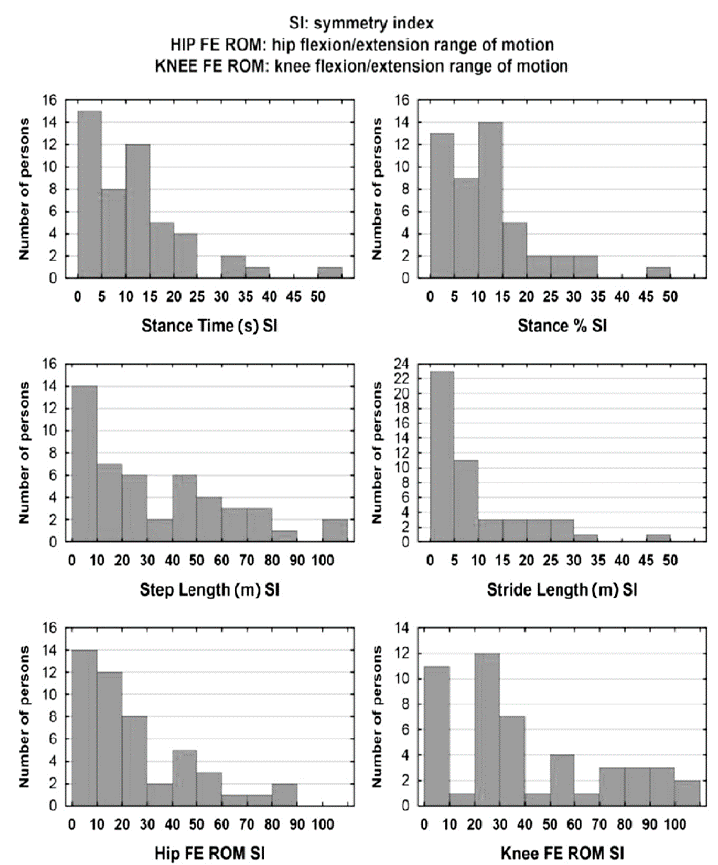
Figure 1. SI distribution for the specific gait parameters. SI, symmetry index; FE, flexion/extension; ROM, range of motion.